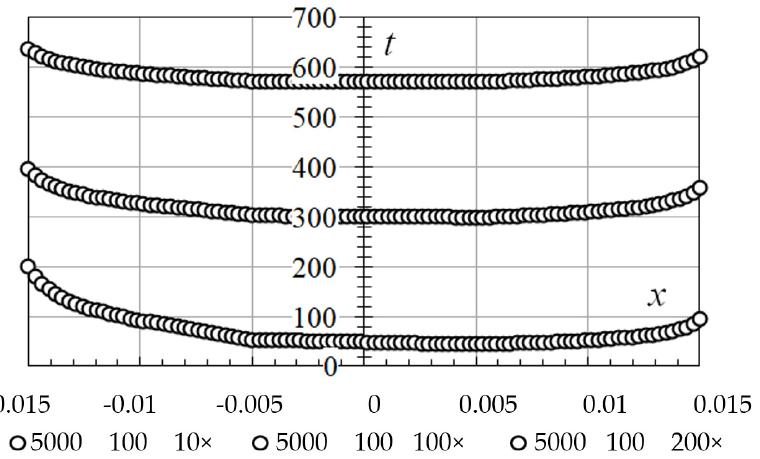
Figure 6. Air temperature profiles in the horizontal central-section ZOX, 100 kg/h ( x [m], t [°C]): bottom-up curves, respectively: 10×; 100×; 200×.